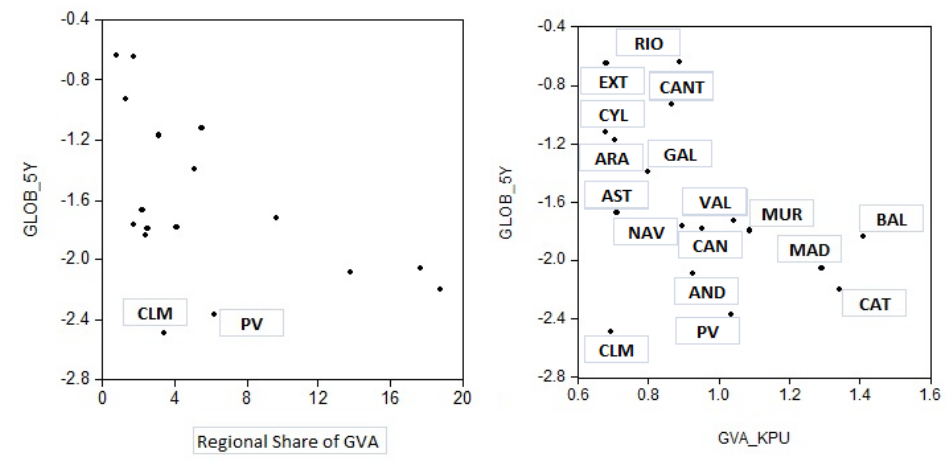
Figure 1: Effects after 5 years of a global negative shock (GLOB 5Y) vs. regional shares of national GVA and the regional ratios GVA/public capital (GVA